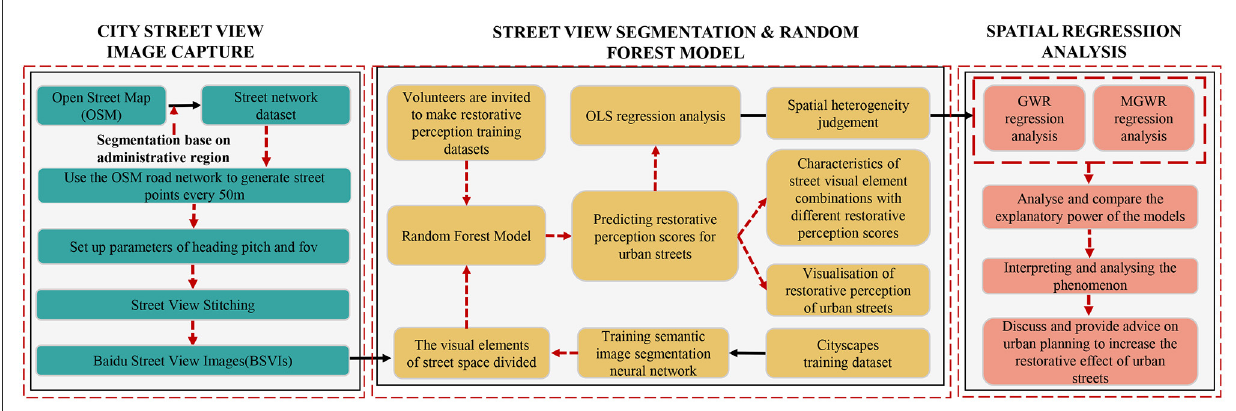
FIGURE1 Overview of our workflow.